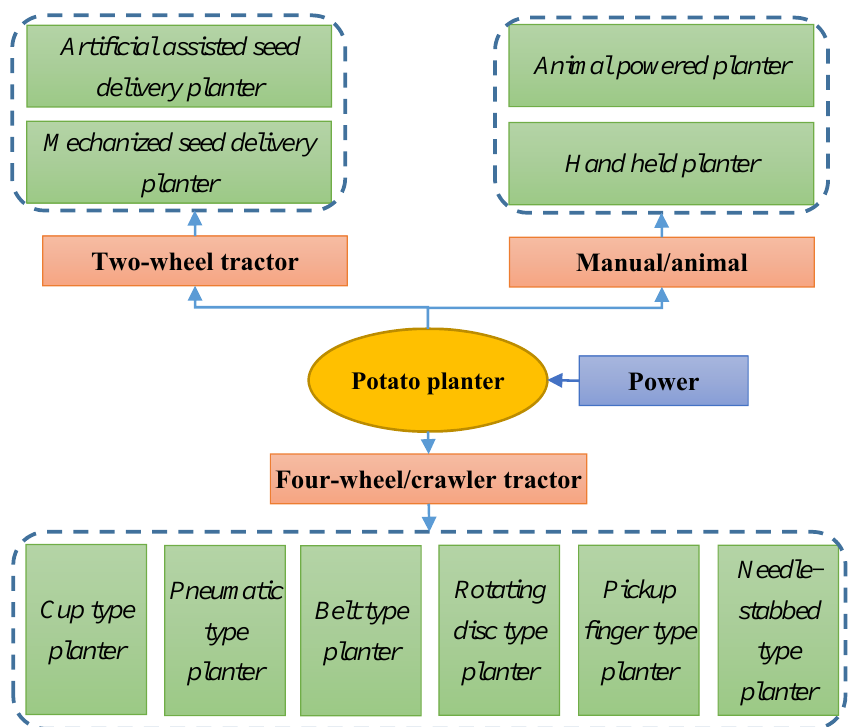
Figure 4. Schematic diagram of categories of potato planter.